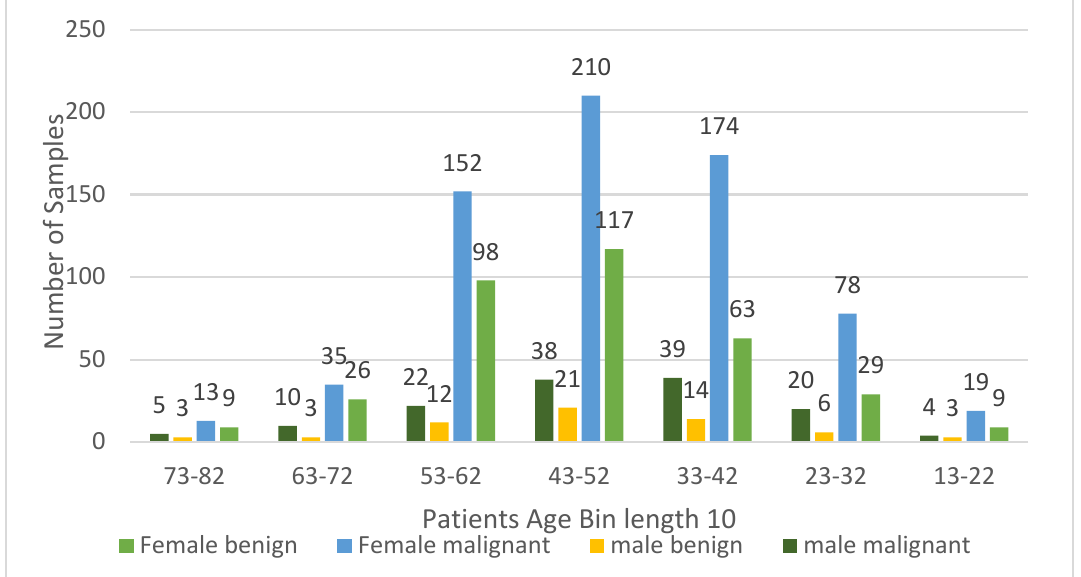
Figure 4. Distribution of patient age range according to gender and patients’ nodule outcomes.